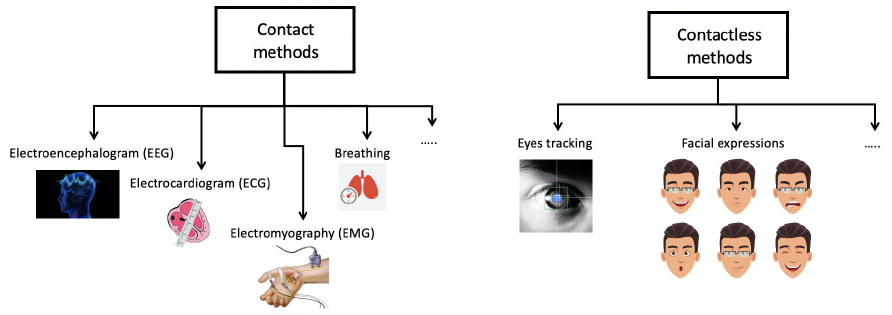
Figure 2. Taxonomy of methodologies for monitoring the driver’s